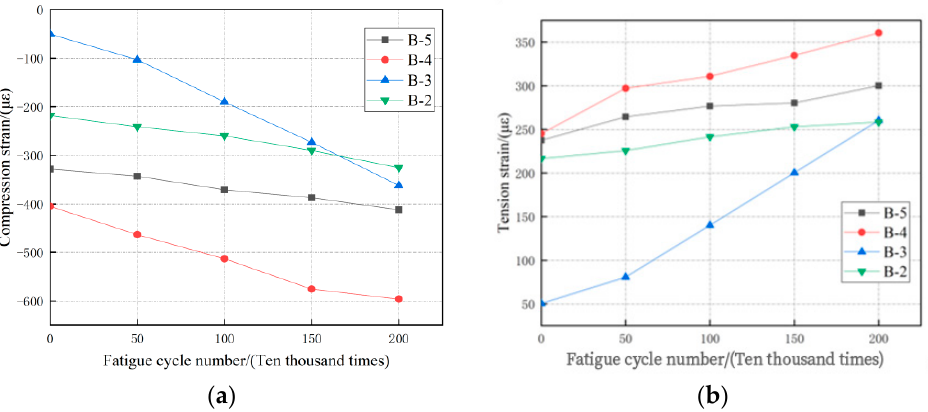
Figure 13. Figures of tensile strain and compressive strain of strengthened test plate during freeze–thaw fatigue process: ( a ) tensile strain; ( b ) compressive strain.